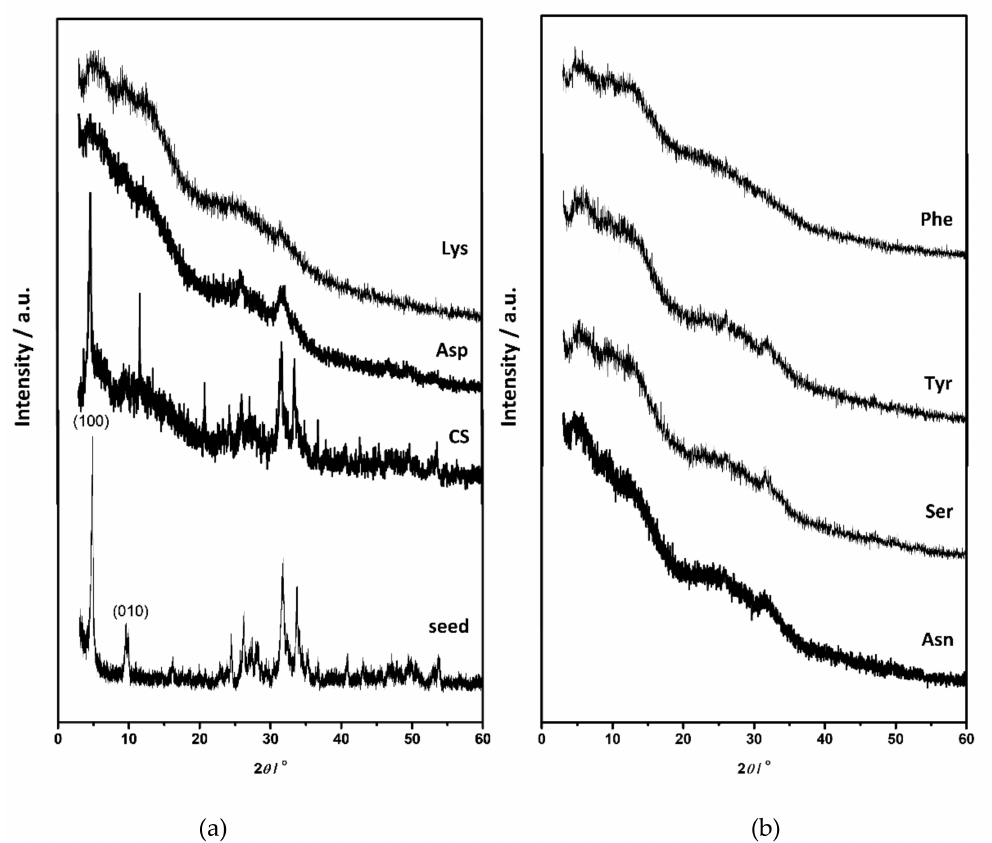
Figure1. PXRDdi ff ractogramsof( a )octacalciumphosphate(OCP)seedcrystalsandprecipitatesformed in the control system (CS) and in the presence of aspartic acid (Asp) and lysine (Lys), ( b ) precipitates obtained in the presence of asparagine (Asn), serine (Ser), tyrosine (Tyr) and phenylalanine (Phe) after aging time corresponding to commencement of stage III in pH vs. time curves in the system c( CaCl 2 ) = c (Na 2 HPO 4 ) = 4.198 mmol dm − 3 , c (NaCl) = 0.148 mol dm − 3 , m (seed OCP) = 1 mg, γ (AA) = 10 ppm, except γ (Phe) = 5 ppm. t = 25 ◦ C, pH initial = 7.4, magnetic